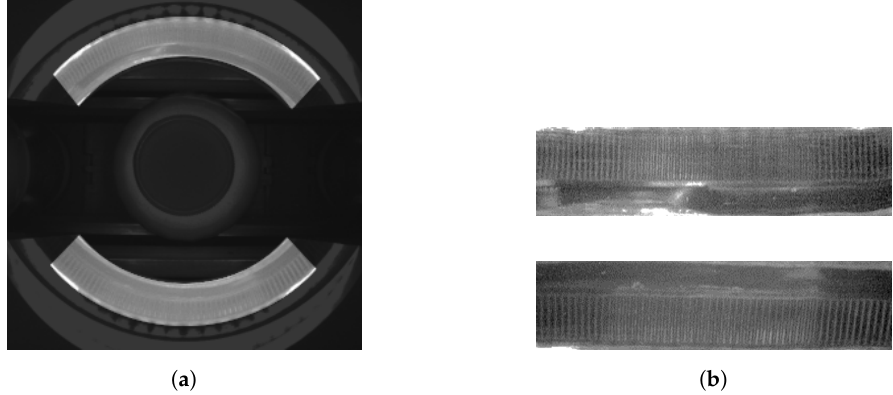
Figure 6. ( a ) The original image acquired with Inspect360+, where the area of the image that represents the cap is highlighted; and ( b ) the upper half and lower half of the cap transformed with the calibration